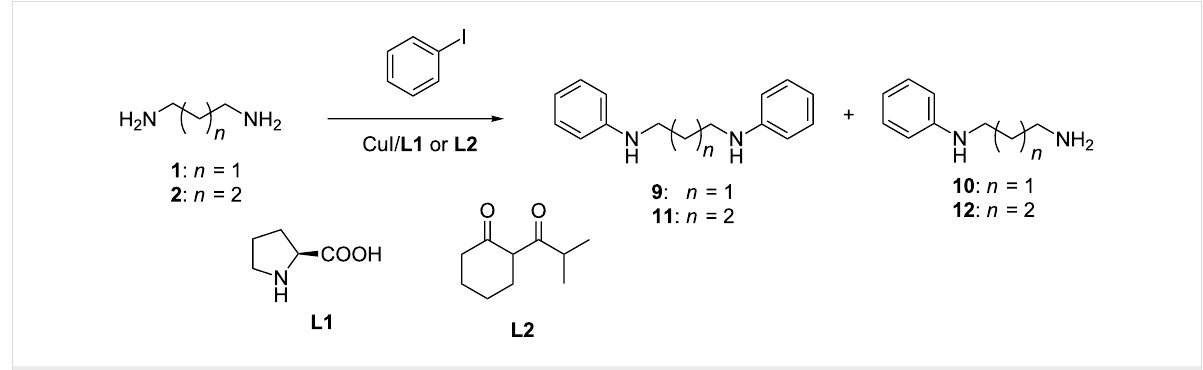
Scheme 1: N,N’ -Diarylation of the diamines 1 and 2 .